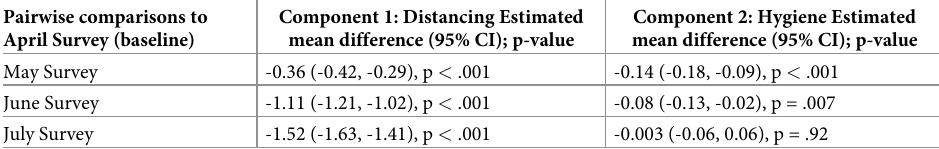
Table 5. Pairwise comparisons between the April (baseline) and subsequent surveys on distancing and hygiene component scores. Pairwise comparisons to April Survey